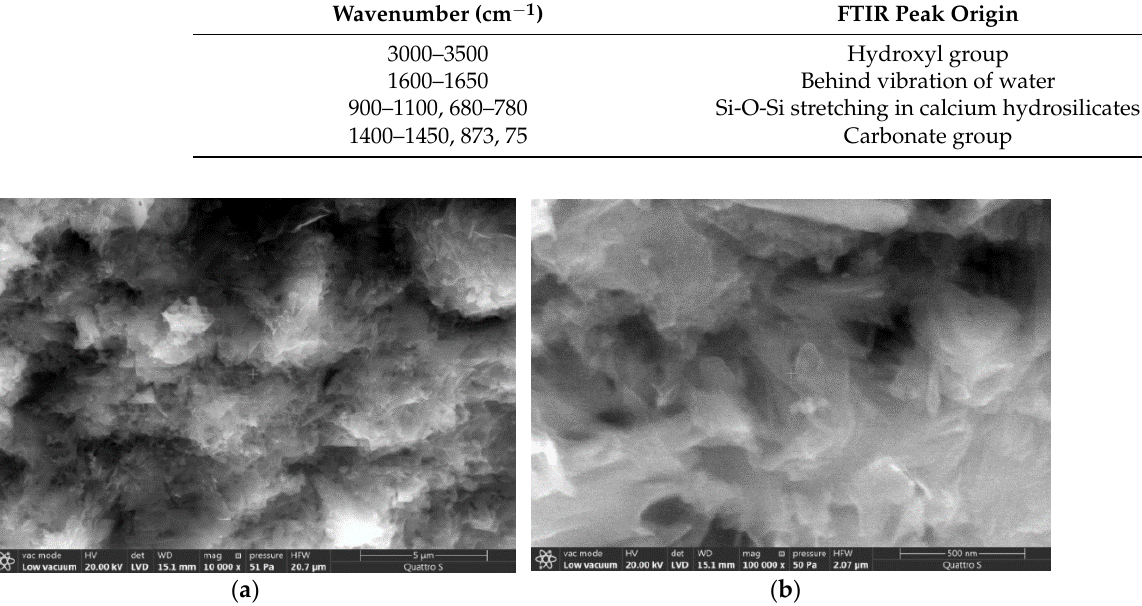
Figure 6. Microstructure of cement matrix of control sample: ( a ) ‐ at 10,000 ‐ fold magnification, ( b ) ‐ at 100,000 ‐ fold magnification.